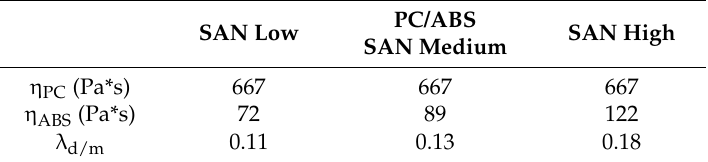
Table 3. Calculation of viscosity ratios λ d/m = λ ABS/PC at a shear rate of 1500 s ´ 1 measured with a capillary